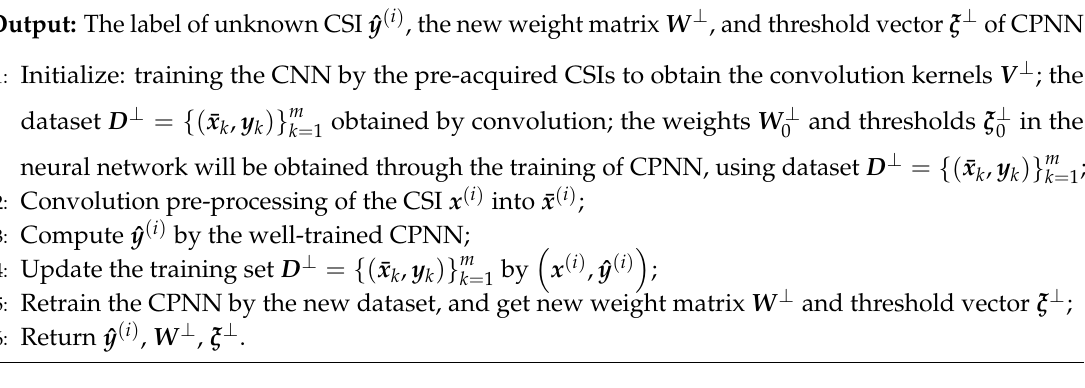
Algorithm 3 CPNN-based sensor nodes’